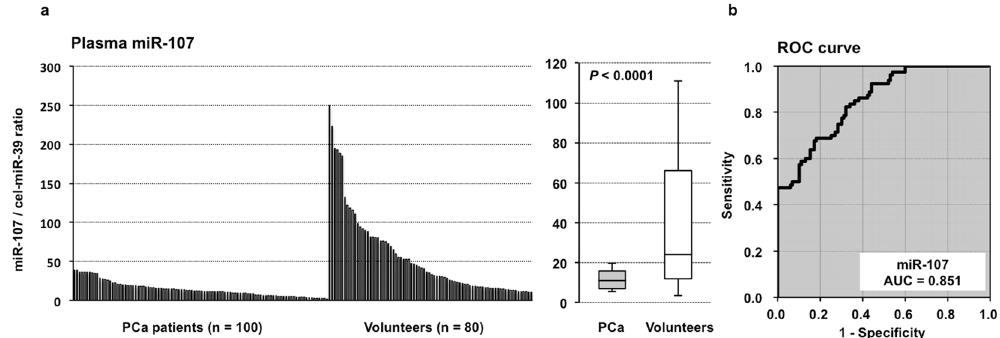
Figure 2. Large-scale analysis of the miR-107 plasma level in PCa patients and healthy volunteers. ( a ) We observed that the plasma level of miR-107 was significantly lower in PCa patients than in healthy volunteers ( P < 0.0001). A waterfall plot also demonstrated a similar result ( P < 0.0001). ( b ) Receiver-operating characteristic (ROC) curves and area under the ROC curve (AUC) values were used to assess the feasibility of using plasma miRNA levels as a diagnostic tool for detecting PCa. We calculated the AUC value to be 0.851. The optimal relative expression cut-off point was found to be 20.5 using the miR-107/cel-miR-39 ratio, with a sensitivity of 82.0%, a specificity of 68.8%, and an accuracy of 82.0%.